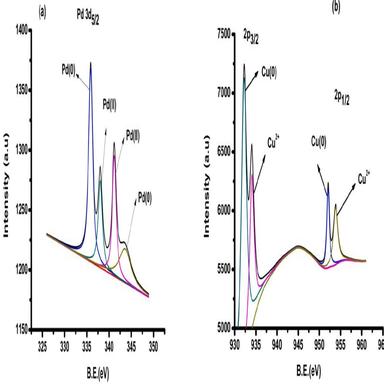
XPS spectra showing the major peaks (a). Pd 3d, (b). Cu 2p.